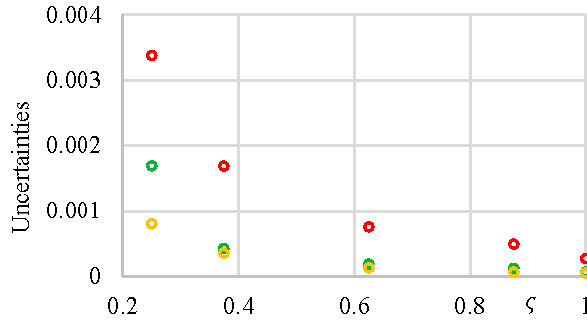
Figure 3. Part of the uncertainties from the measurements.